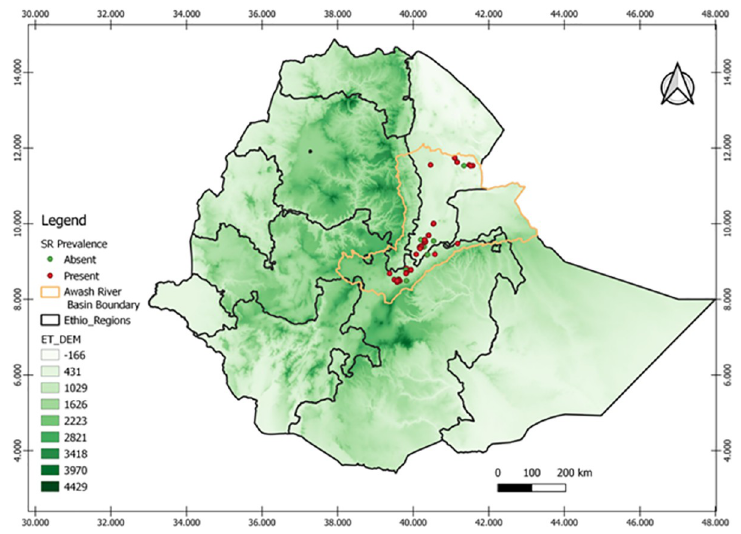
Fig 4. The effect of attitude on the Pgt disease distribution the ET-DEM shows the altitudinal gradients the greener the highland area “reprinted from [ref] under a CC BY 4.0 license, with permission from [PLOS ONE], original copyright